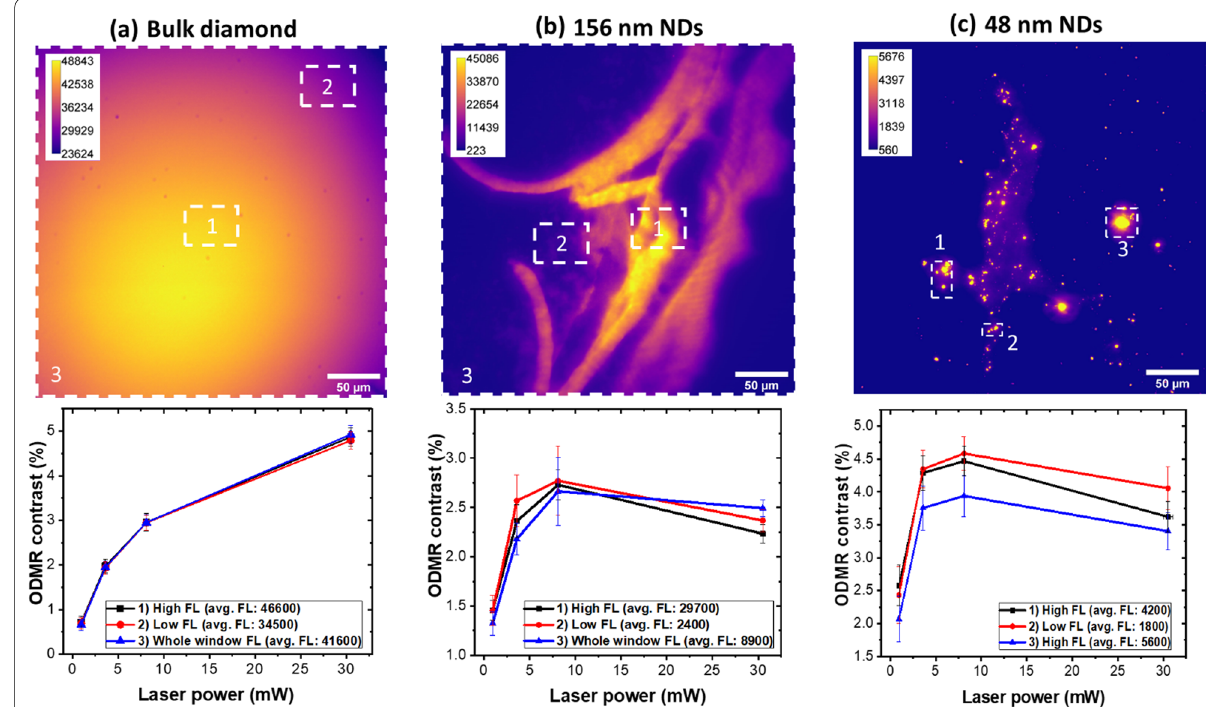
Fig. 3 Comparison of ODMR contrast at different laser powers for bulk diamond and NDs. ODMR curves are extracted from three different regions of interest (ROIs) containing the bright spots that indicate presence of NV centers (see wide‑field fluorescence images). As laser power increases, in bulk diamond the ODMR contrast increases, consistently with larger NV − polarization levels ( a ). Conversely, in NDs of both sizes, the ODMR contrast increases up to 8.1 mW and decreases at higher laser powers, resulting in a non‑monotonic behavior ( b , c ). The homogeneity of bulk diamond is reflected in the uniform values of ODMR contrast observed in the various ROIs with different levels of FL (values in the caption). On the contrary, NDs show non‑uniform deposition and aggregation, resulting in a region‑dependent ODMR contrast. 156 nm NDs were less inhomogeneous than the 48 nm NDs. The laser power dependence of the ODMR signal was similar in all the ROIs extracted, for both NDs